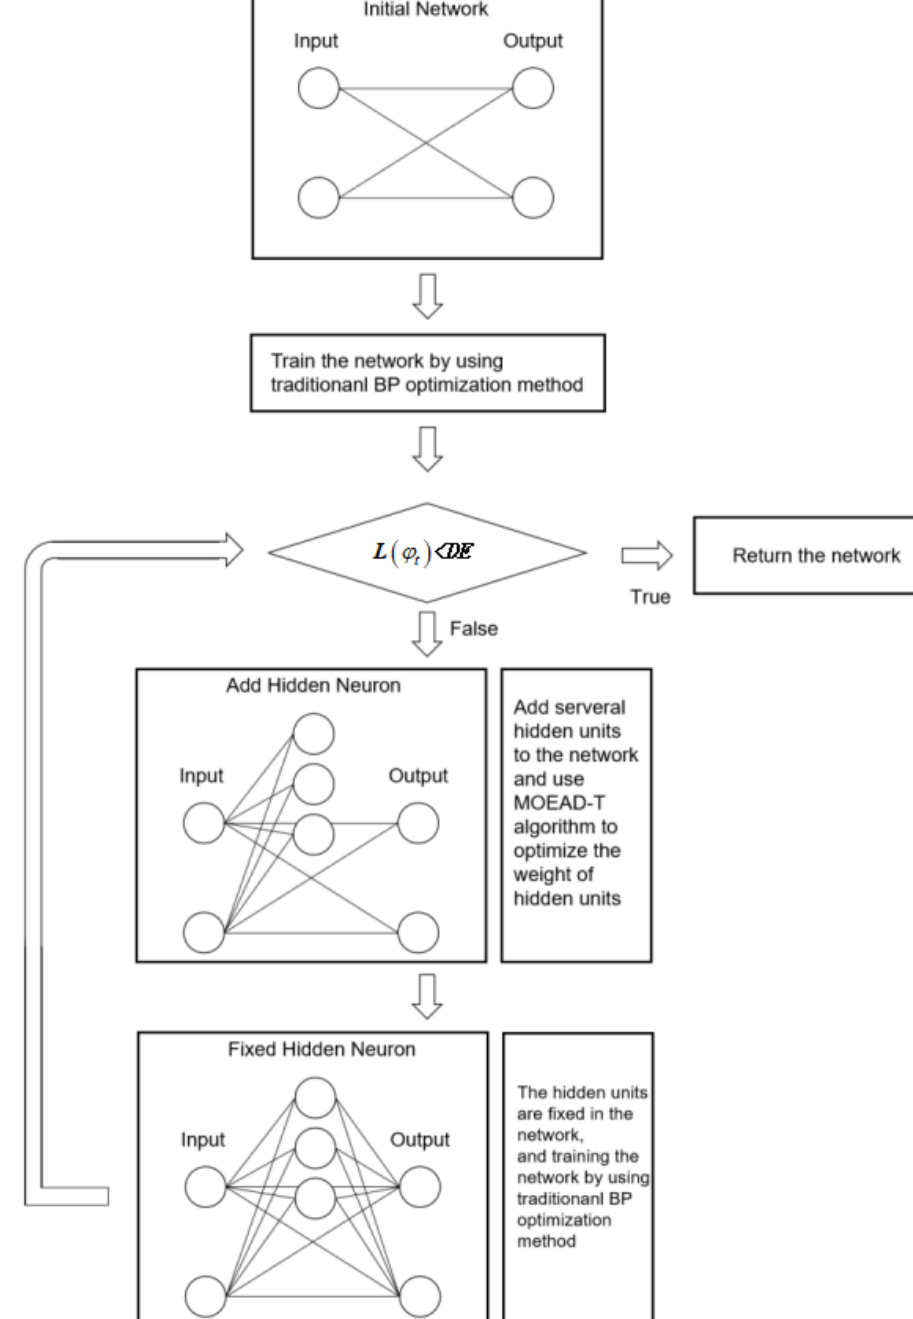
Figure 4. Steps of CCNN-MOEA-T algorithm.